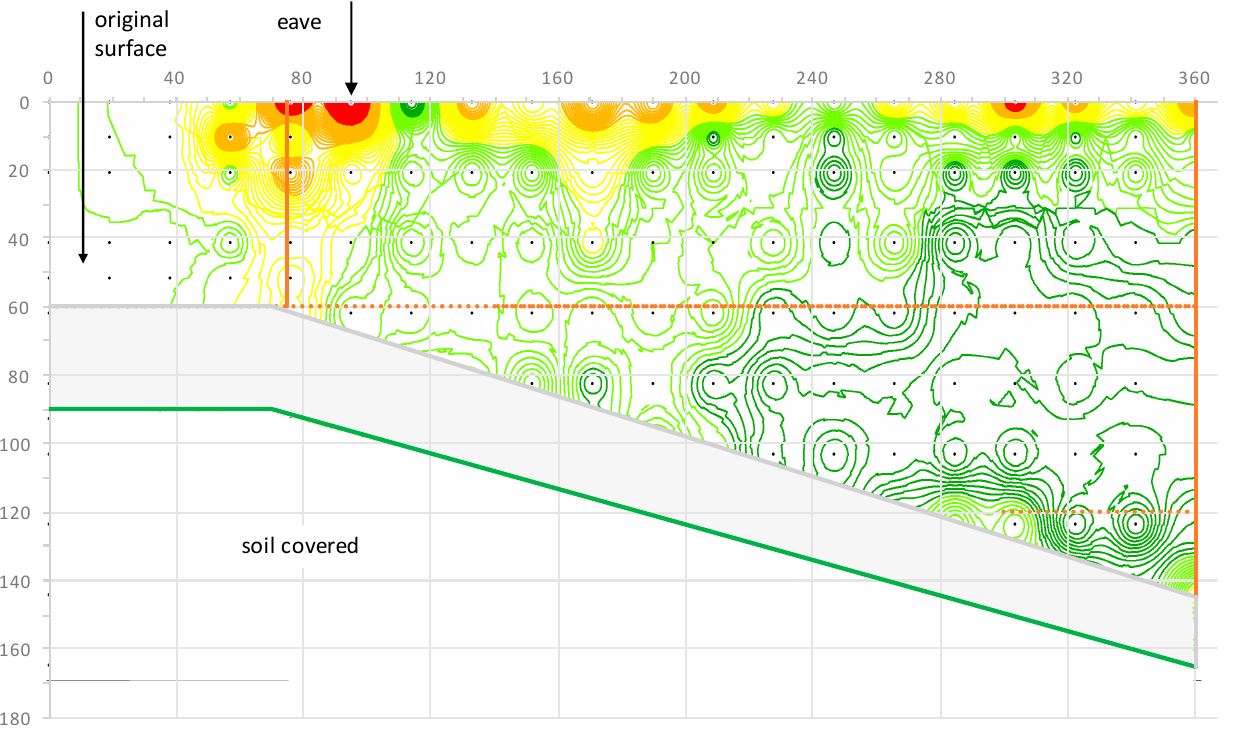
Figure 14. Observed decay on the eastern face of wall 1. Contour intervals 2 mm. Contours (relative to the patch of original surface): dark green 11–22; green 0–10; yellow − 13– − 1; orange − 29– − 14; red − 50– − 30.